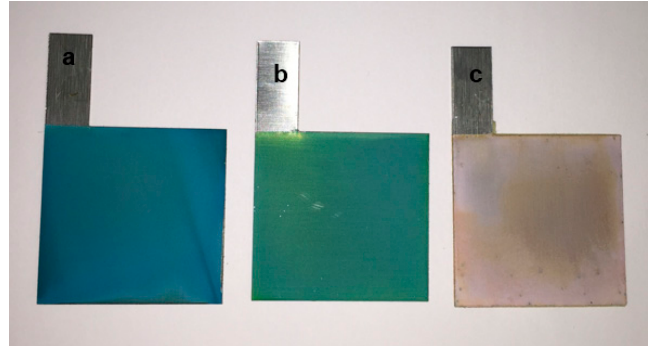
Figure 2. As-deposited stainless steel electrodes obtained at ( a ) 25 °C, ( b ) 60 °C, and ( c ) 95 °C.